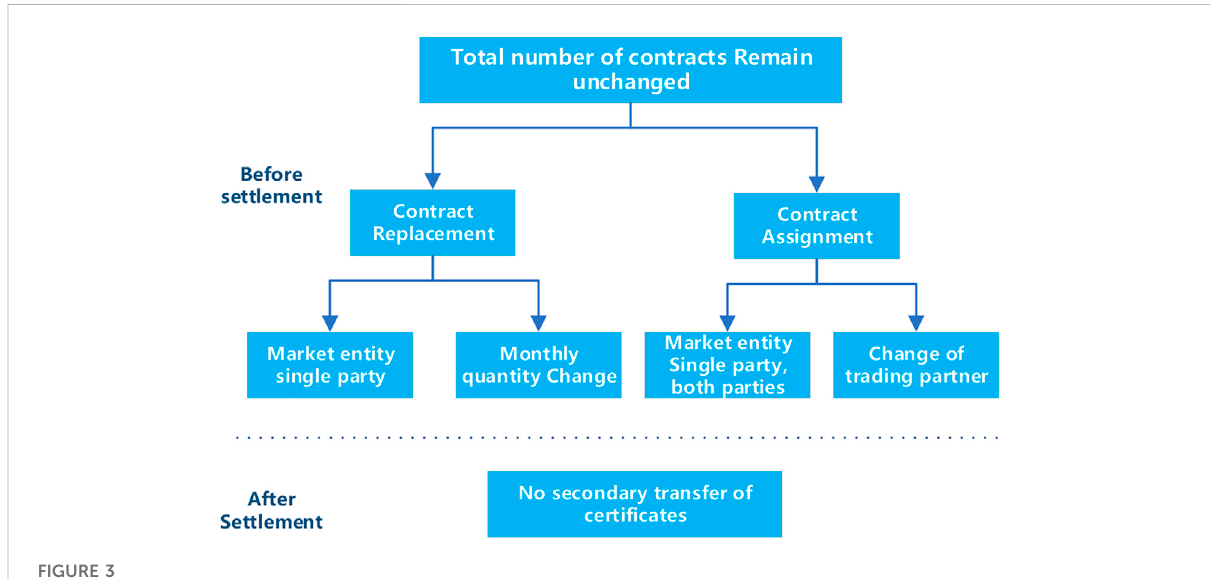
FIGURE 3 Deviation adjustment